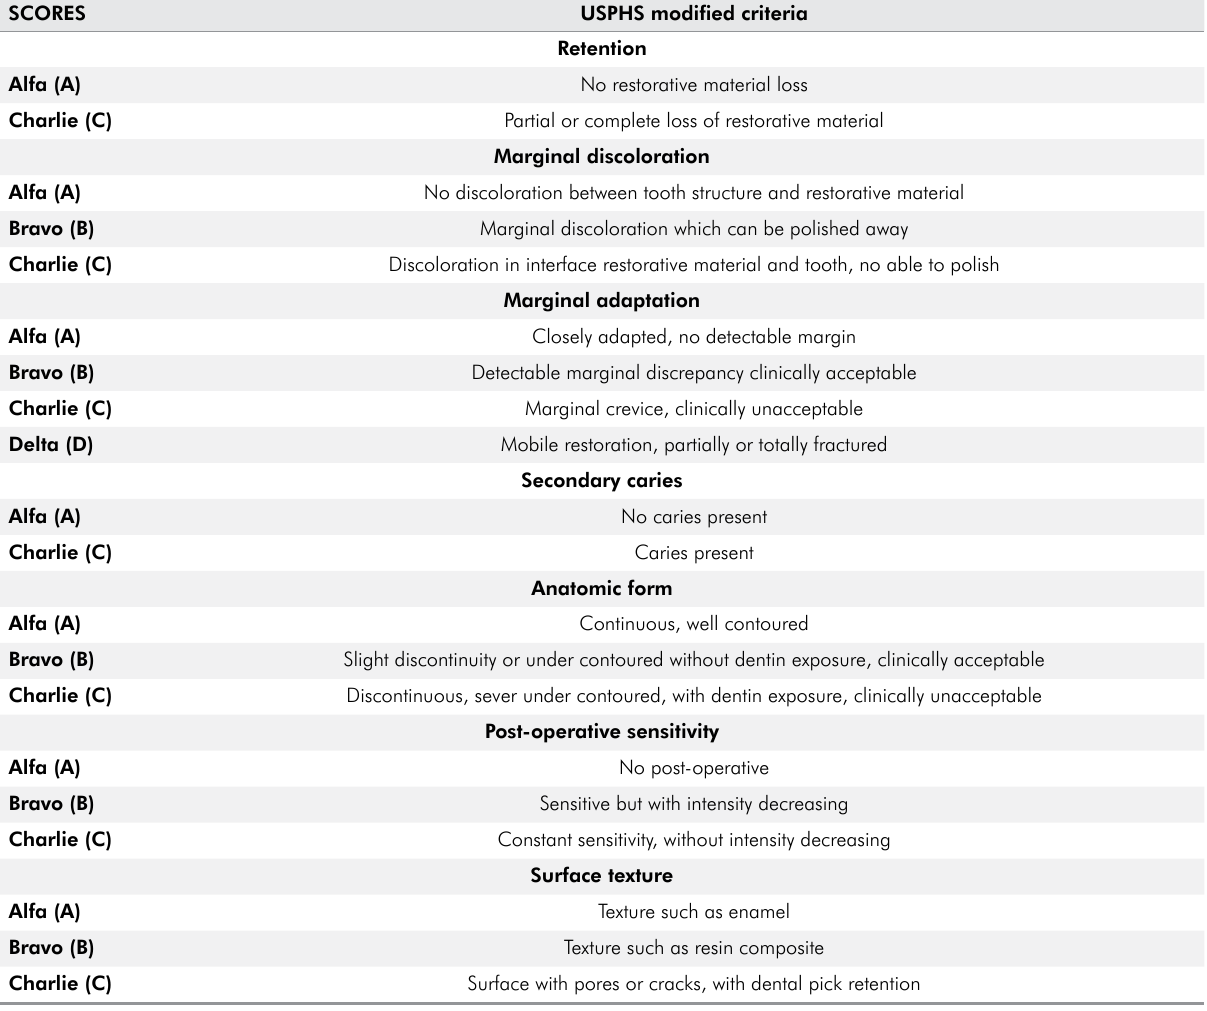
Figure 2. USPHS modified